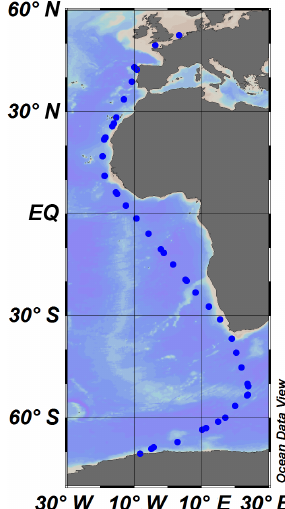
Figure 4. Locations of radiosonde launches performed from PO- LARSTERN during cruise ANT-XVII (14 December 1999 to 20 Jan- uary